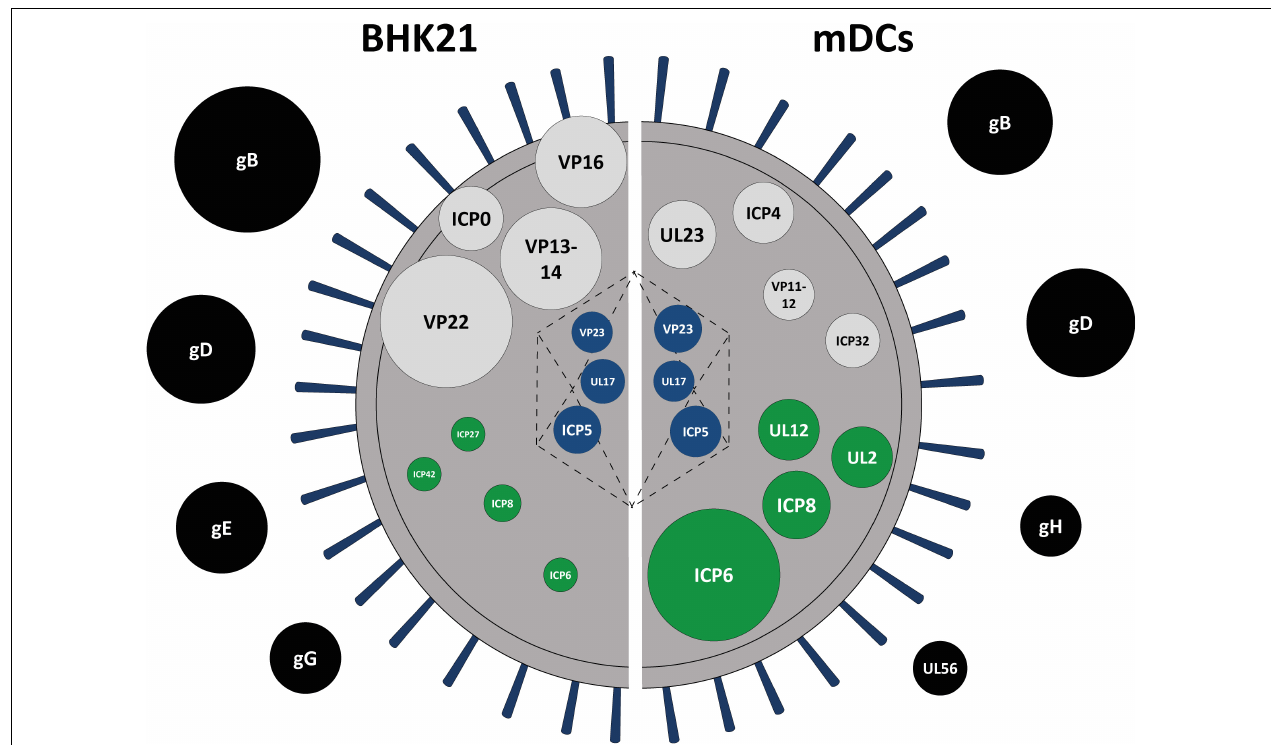
FIGURE 5 | Schematic protein signature of HSV-1 L-particles derived from HSV-1-infected BHK21 cells and mDCs. Graphical comparison of the viral protein signature of HSV-1 L-particles derived from infected BHK21 cells (left part) and mDCs (right part) based on the mean intensity of all samples (BHK21: four samples, mDCs: three samples) as shown in Tables 1 , 2 . The top abundant hits are shown as circles, each representing a single viral protein. The diameter was adapted according to the relative signal intensities of the depicted viral proteins. The proteins are categorized regarding their predicted localization within the virion, i.e., tegument (black), envelope (gray), capsid (blue), or non-structural proteins